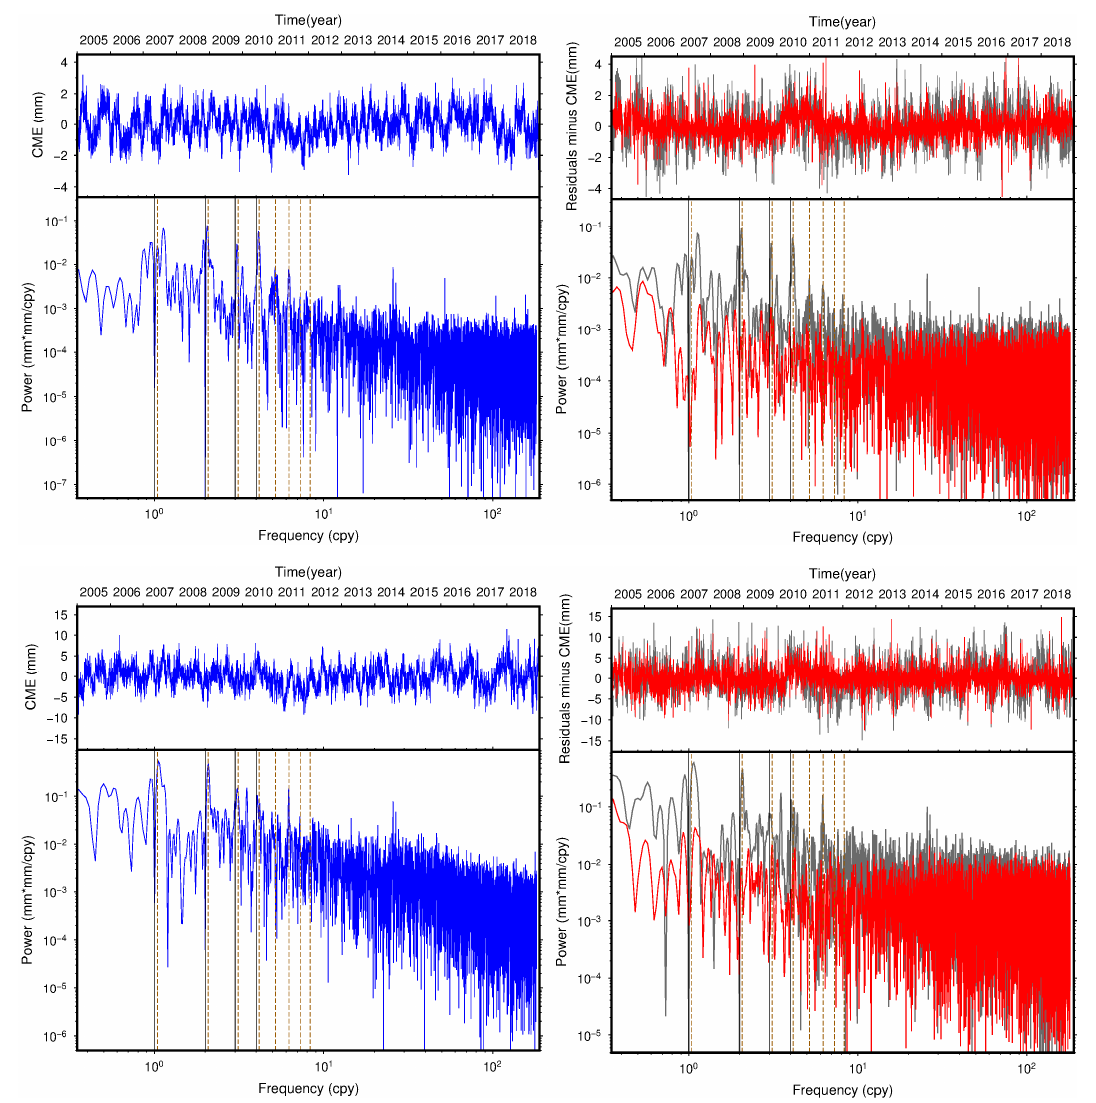
Figure 7. Power spectra of CME, unfiltered and filtered residual time series of station SCIA for the north (top panels), east (middle panels), and up (bottom panels) components. Left panels: CME and its power spectra (blue). Right panels: unfiltered (gray) and filtered time series (red), together with their corresponding power spectra. The vertical black-solid lines indicate harmonics of 1.0 cpy, and brown-dash lines indicate harmonics of 1.04 cpy.